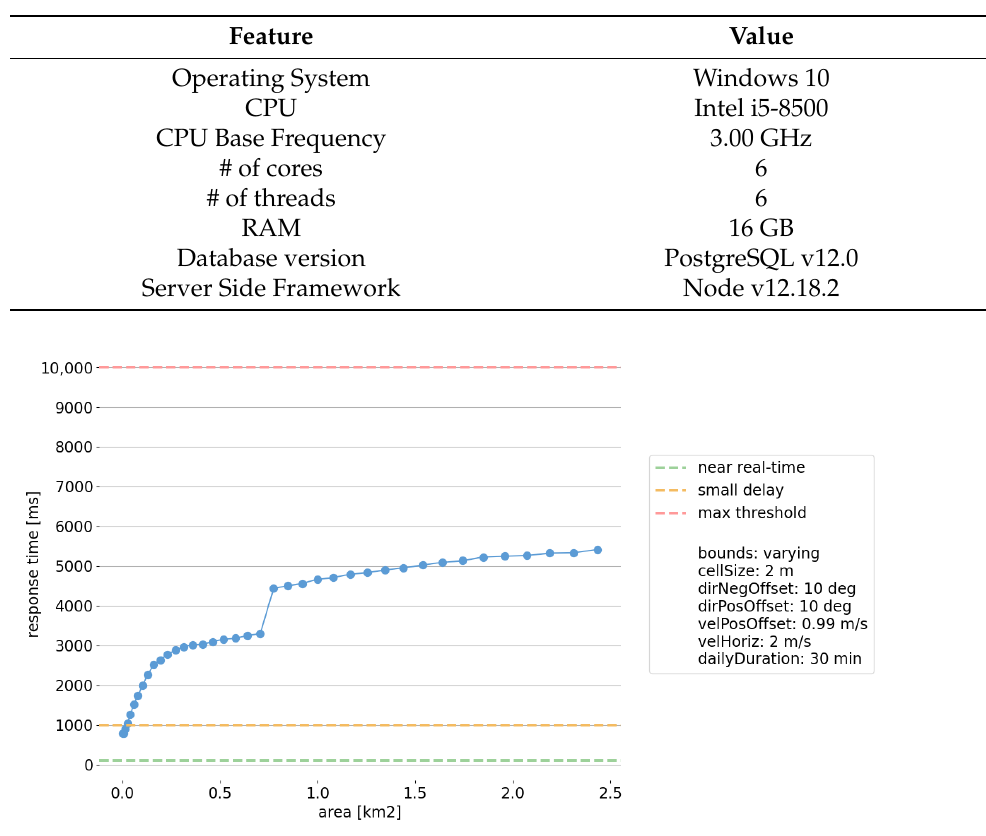
Figure 14. The visual analytics platform remained interactive even in larger spatial extents.